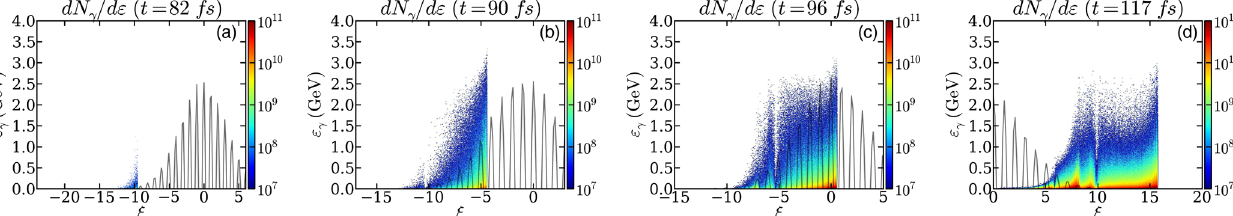
FIG. 6. Photon energy spectra (transversely integrated, in photons per GeV) before (a), during (b,c) and after (d) the laser-beam collision, as a function of the relative distance ξ ¼ ½ x − x p ð t Þ(cid:4) = λ 0 to the laser intensity peak position x p ( λ 0 being the laser wavelength).